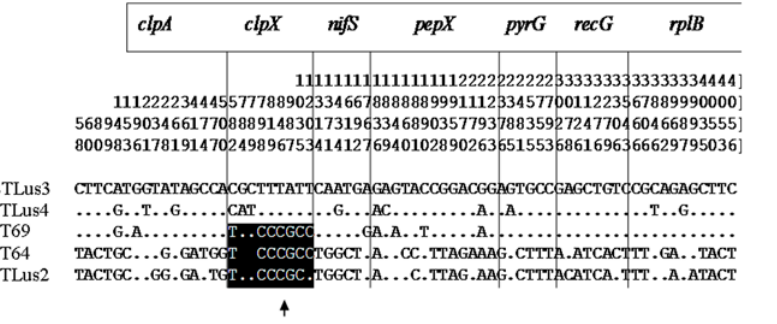
Figure 6. Variable sites for each housekeeping gene shown for ST64, ST69, STLus2, STLus3 and STLus4. The numbers above the sequences refer to the position in the concatenated alignment. Regions corresponding to the individual genes are separated by a line and gene names are given on the top. The likely recombination event between ST64 and ST69 in clpX is indicated by an arrow.